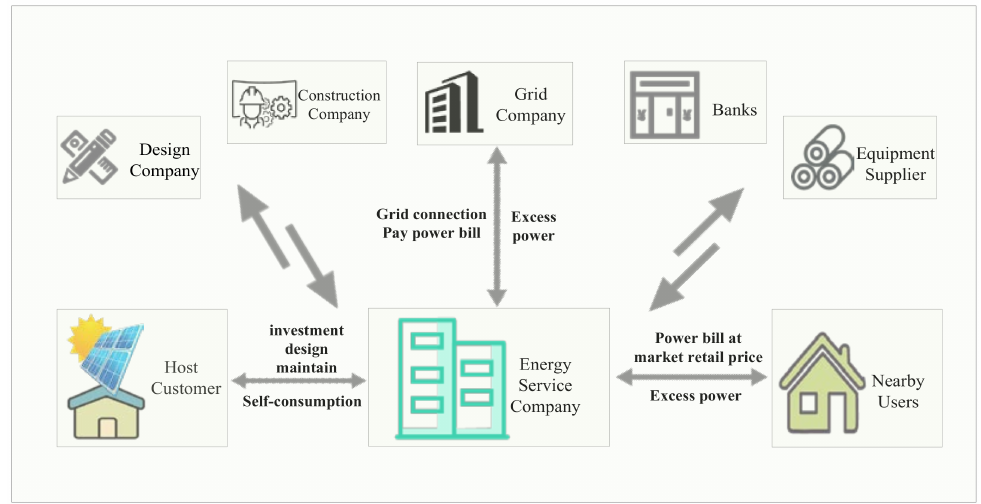
Figure 2. Mechanism of energy performance contracting (EPC) business